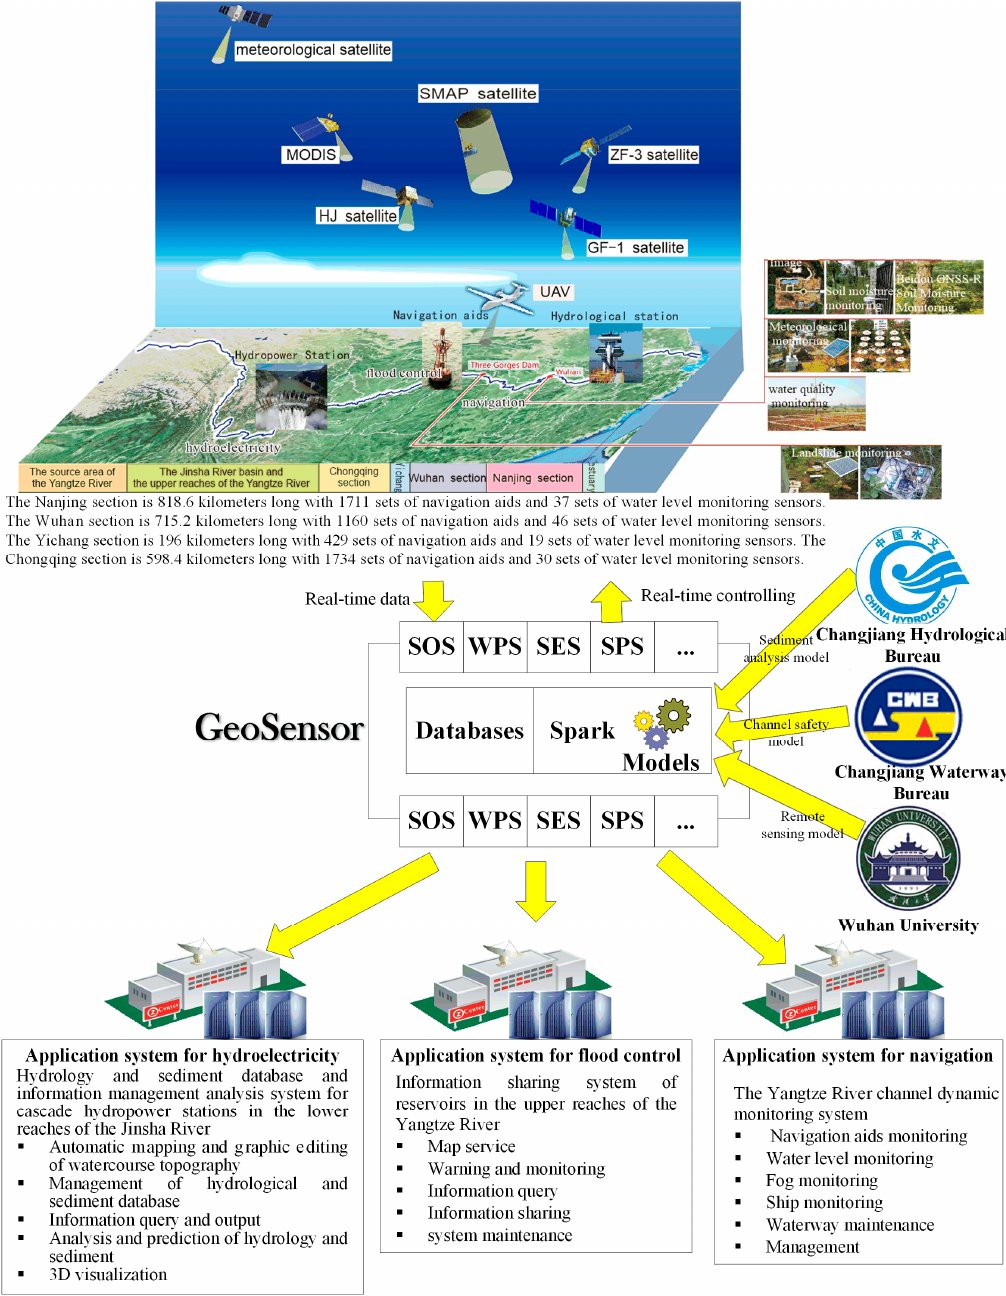
Figure 6. The comprehensive web-based sensor based on the GeoSensor in the Yangtze River basin.